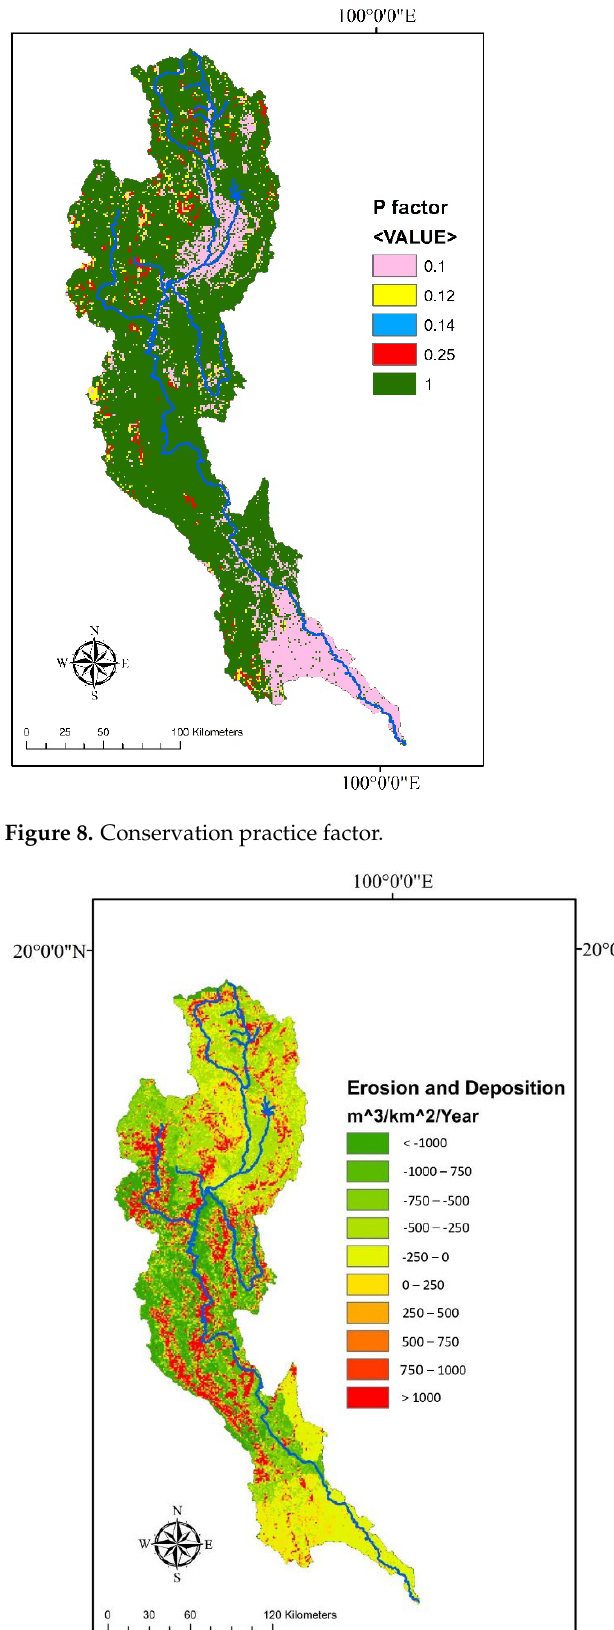
Figure 7. Cover-management factor map.